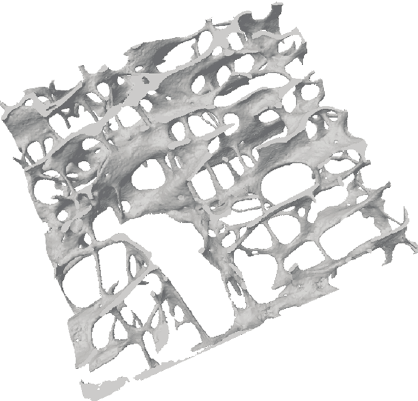
Table 1: Descriptive statistics for all parameters (mean ±